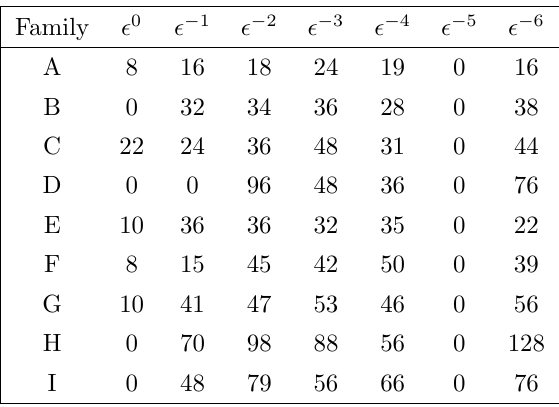
Table 3 . Number of d log integrands with speci(cid:12)c degree of